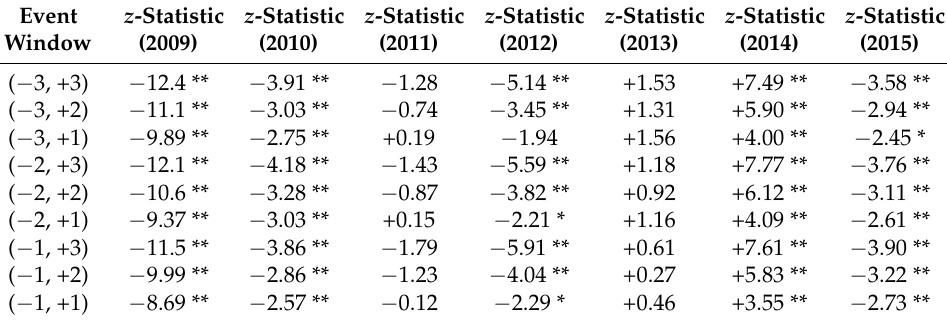
Table 1. z -Statistics (year wise global branded